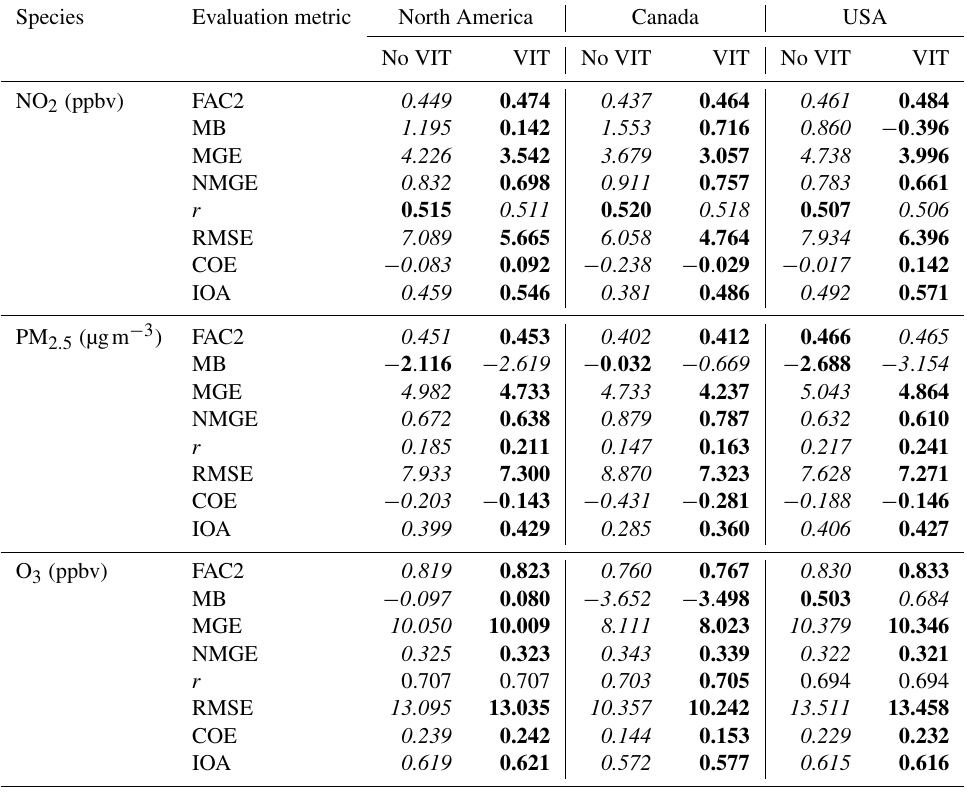
Table 2. Model performance for NO 2 , PM 2 . 5 , and O 3 in the 10km grid cell size North American domain. No VIT refers to simulations without vehicle-induced turbulence, and VIT refers to the simulation incorporating vehicle-induced turbulence. Bold-face print identifies the better score, italics the worse score, and regular font indicates similar performance between the two simulations for each metric and chemical species